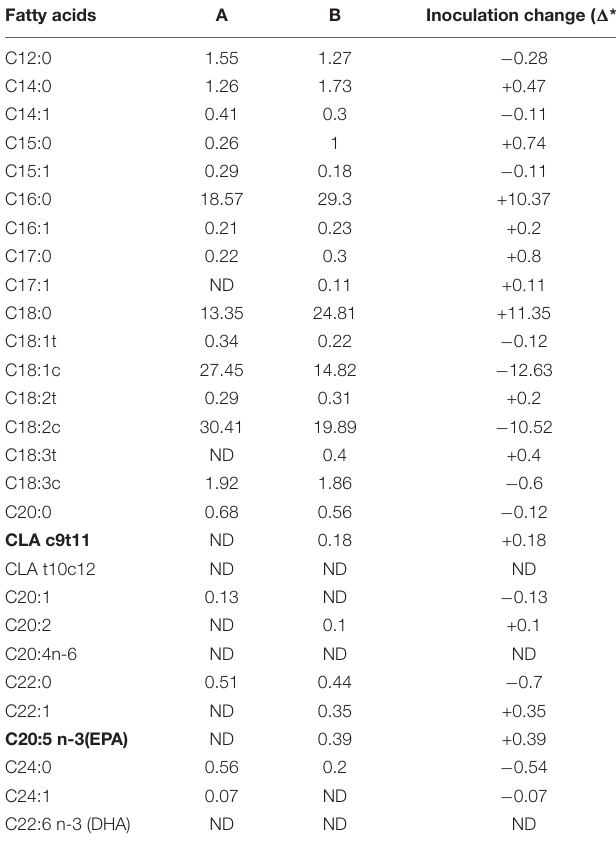
TABLE 4 | Fatty acids composition (% total fatty acids) of the SPC with (B) and without Bifidobacter lactis